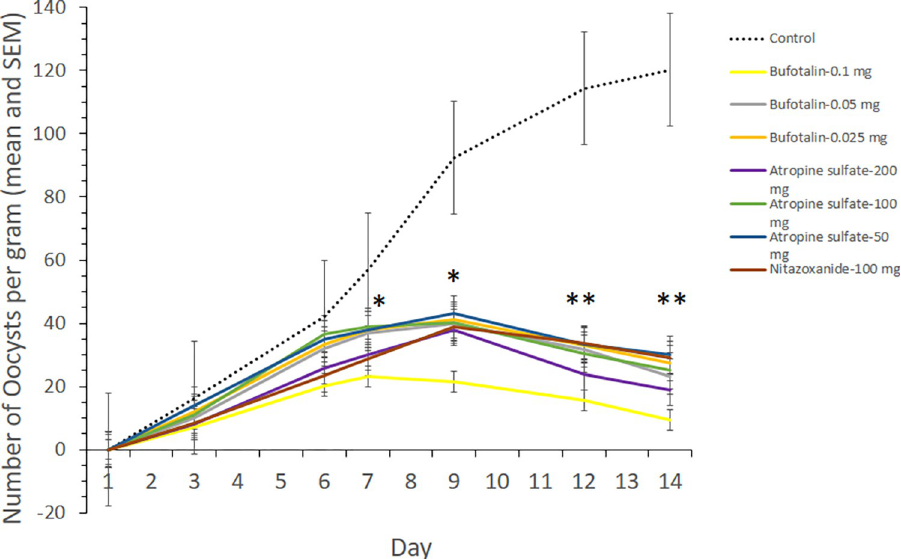
Fig 4. In vivo infected mice treated with compounds showed growth inhibition of C . parvum . Two compounds (atropine sulfate and bufotalin) reduce the number of oocysts shedding in mice compared to control drugs. C . parvum oocysts were inoculated orally into SCID mice. Infected mice left untreated served as a positive control. The mice were treated with 200 μ l of atropine sulfate or bufotalin 3 days after infection (i.e., from Day 3) until Day 13 at three different concentrations for each compound (atropine sulfate: 200, 100, and 50 mg/kg; bufotalin: 0.1, 0.05, 0.025 mg/kg). Nitazaxonide was administered orally at 100 mg/kg as a comparative drug. The number of oocysts in the feces was determined by using the sugar flotation method, and the total number of oocysts per gram (OPG) was calculated. Data shown are the mean and SEM (n = 3 mice in each group). Asterisks indicate levels of statistical significance as evaluated by the difference in parasitemia between the control and drug-treated groups by use of a one-way ANOVA with the post-hoc Tukey HSD test, � : p < 0.05, �� : p <